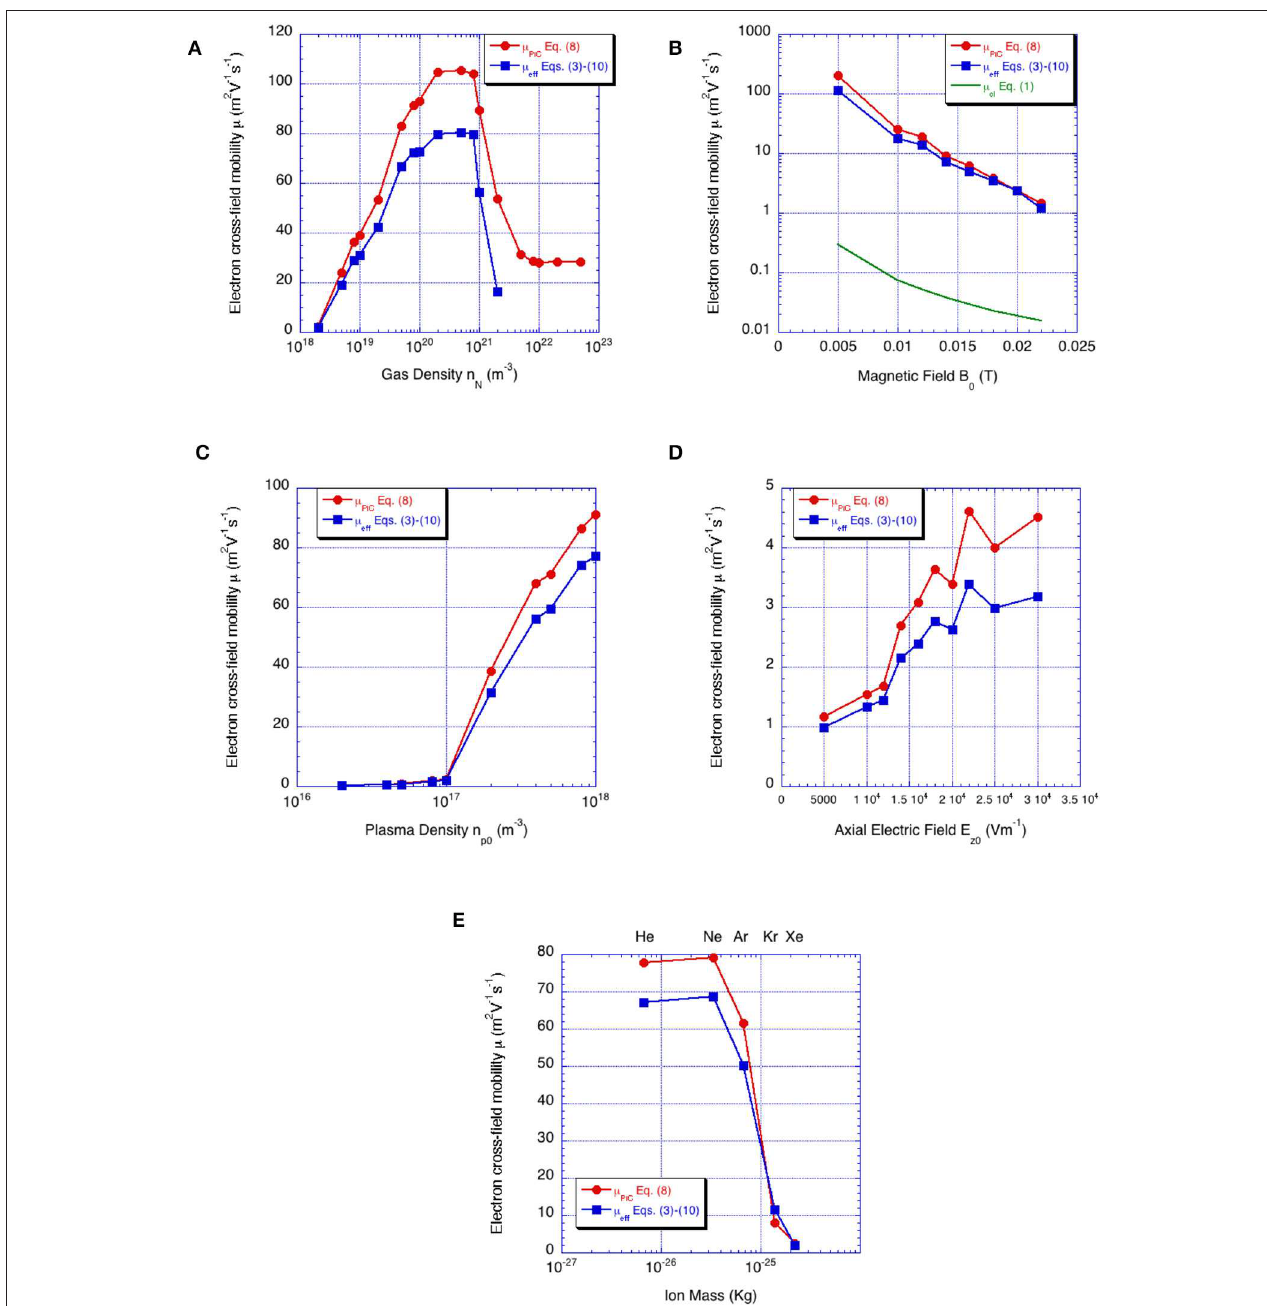
FIGURE 10 | Calculated steady state cross-field mobility as a function of (A) xenon gas density, (B) magnetic field, (C) plasma density, (D) axial electric field and (E) ion mass, using data reported in Table 1 .